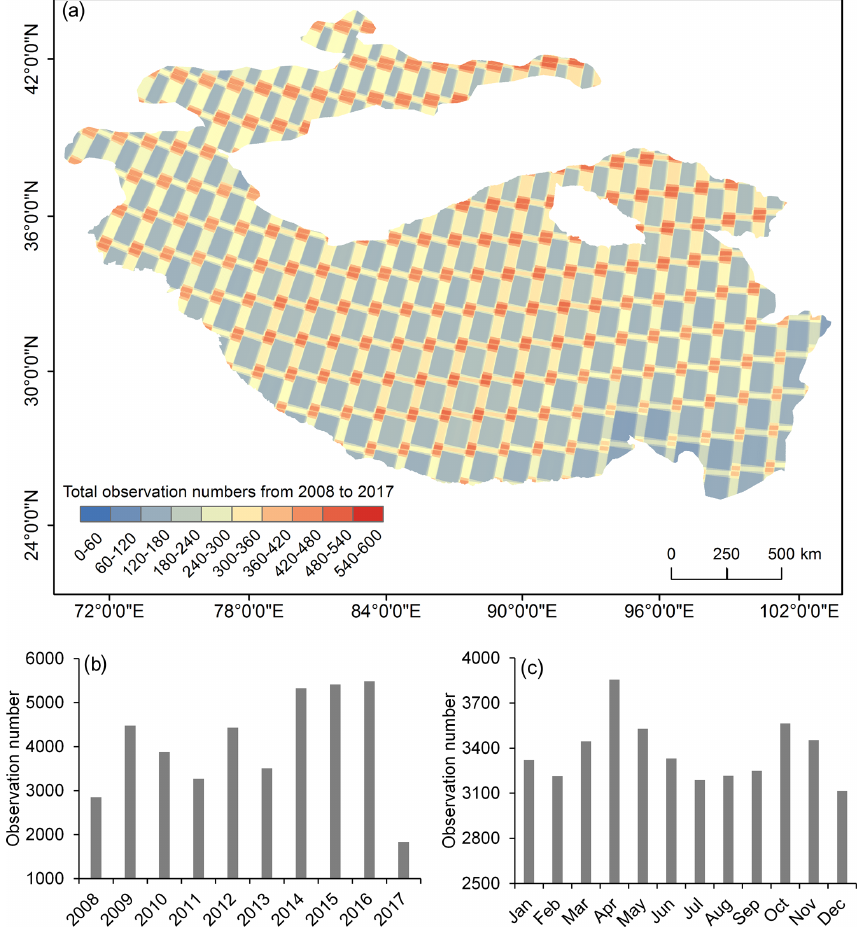
Figure 2. (a) The distribution of total observation numbers from all GEE Landsat scenes, along with these numbers broken down by (b) year and (c)